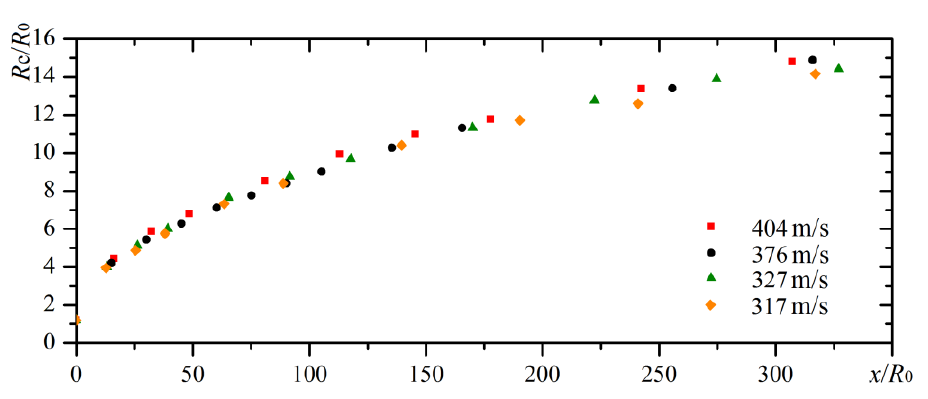
Fig. 5. Experimental profiles of cavities at different speeds of bodies.